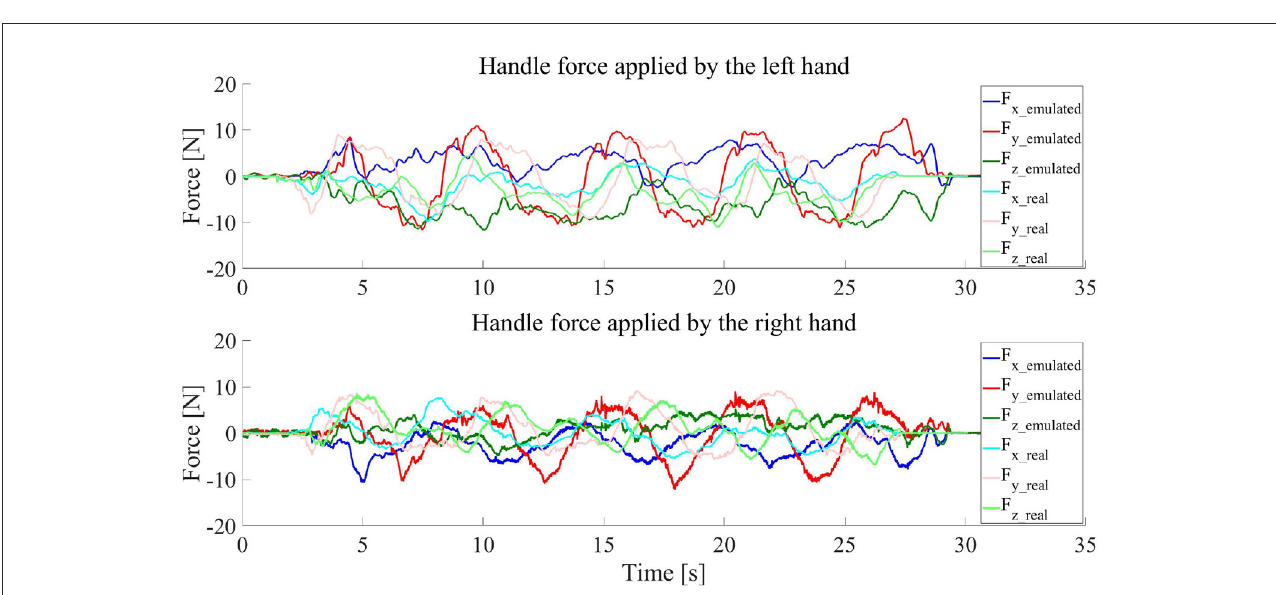
FIGURE12 Handle forces applied by the operator hands when the operator used the real and emulated systems to move the end-effector of the virtual robot seen in the VR scene along a circular trajectory for four cycles.